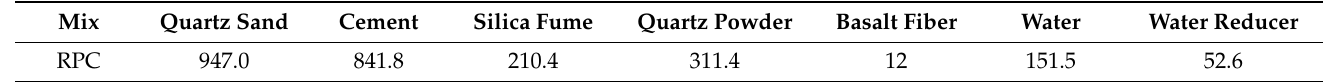
Table 3. The mixture proportion of reactive powder concrete (RPC) (kg/m 3 ).